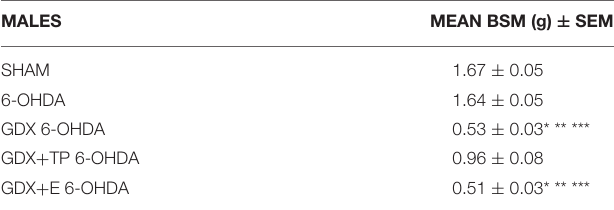
TABLE 2 | Group mean weights of the androgen-sensitive bulbospongiosis (BSM) mass [in grams ± standard error of the mean (SEM)] for gonadally intact sham-operated (SHAM) and 6-hydroxydopamine lesioned (6-OHDA) males and for the males that were gonadectomized (GDX), GDX and supplemented with testosterone propionate, or GDX supplemented with 17 β -estradiol and 6-OHDA lesioned (GDX 6-OHDA, GDX + TP 6-OHDA, GDX + E 6-OHDA,